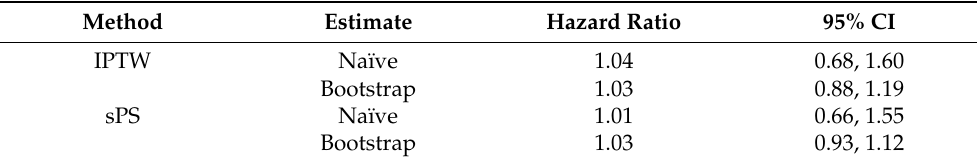
Table 5. Hazard ratios for cancer-related deaths in patients with moderate/severe vs. none/mild ESAS anxiety symptoms at diagnosis.